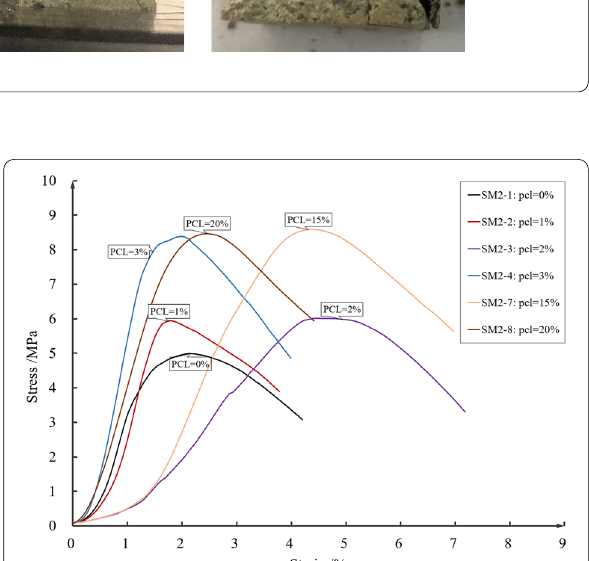
Fig. 17 PCL‑cement mortar stress–strain relationship curves with various PCL